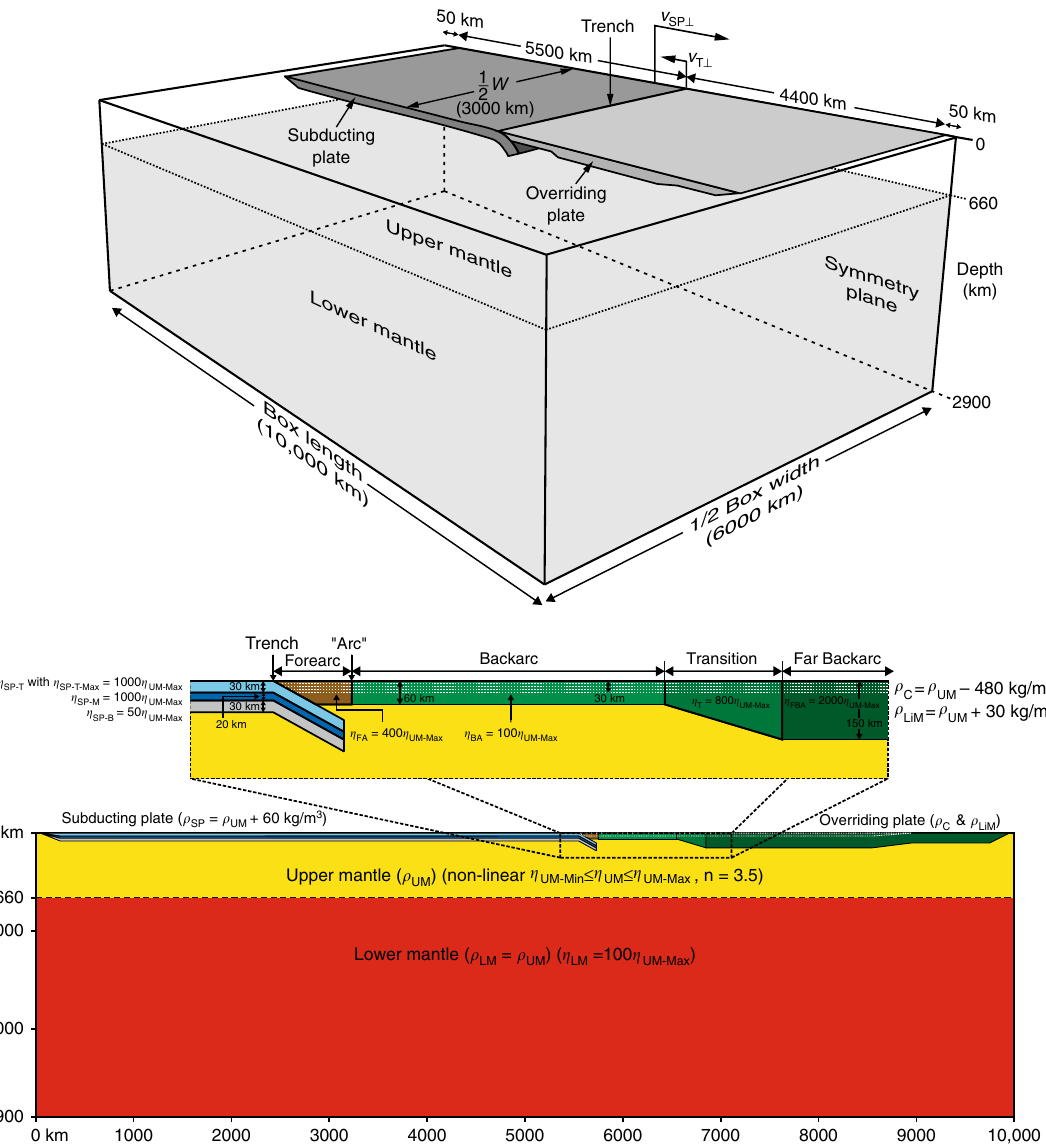
Fig. 6 Numerical model set-up to investigate time-evolving subduction of a 6000 km wide subduction zone comparable to the South American subduction zone in a very large three-dimensional domain with a layered whole-mantle reservoir. a Three-dimensional perspective view. b Cross-sectional view through the centre of the subduction zone (symmetry plane in a ). The model includes a layered negatively buoyant oceanic subducting plate with three layers with different viscosity (top, middle and bottom) and a layered continental overriding plate with two layers with different density (crustal layer and lithospheric mantle layer). Note that v T ⊥ = trench-normal trench velocity (oceanward retreat is positive), v SP ⊥ = trench-normal subducting plate velocity (trenchward is positive), W = slab width, ρ UM = sub-lithospheric upper mantle density, ρ LM = lower mantle density, ρ SP = subducting plate density, ρ C = continental crustal density, and ρ LiM = lithospheric mantle density. See Methods section for more the centre compared to the edges. Please note, however, that the that the convex geometry develops during continuous trench dimensionalized velocity values of the numerical model directly retreat (Fig. 3a, e), which is slowest in the centre and increases depend on the choice of absolute viscosity for the mantle in towards the lateral slab edges with a maximum at ~500 km from nature (Methods section). the edges. Average trench retreat velocities as deduced from The evolution of trench curvature in the model (Fig. 3e) agrees Fig. 3e give a minimum of 1.1 cm per year for the centre and a with the development of the convex-shaped Bolivian orocline in maximum of 1.3 cm per year near the edges over a 182.6 Myr the Central Andes 16, 18, 19 , which has been developing since the period. Such rates are of the same order of magnitude as average Cretaceous as implied by paleomagnetic rotations 15 . Jurassic- South American trench retreat rates for the last ~200 Myr (~1.8 ± 0.3 cm per year in the centre and ~1.9 – 2.1 ± 0.3 cm per year Cretaceous rocks record a range of anticlockwise rotation values (~ 5 – 70°) north of the Arica bend and clockwise rotation values near the edges) and are comparable to observed present-day rates (0 – 50°) south of the bend 15 . The directions of these rotations of trench migration ( − 0.7 to 0.6 cm per year in the centre and 1.1 (anticlockwise in the north and clockwise in the south) are to 1.6 cm per year in the north and south) 43 . The trench velocities in nature also show the pattern of slower trench retreat rates in consistent with the oroclinal rotations observed in the model.